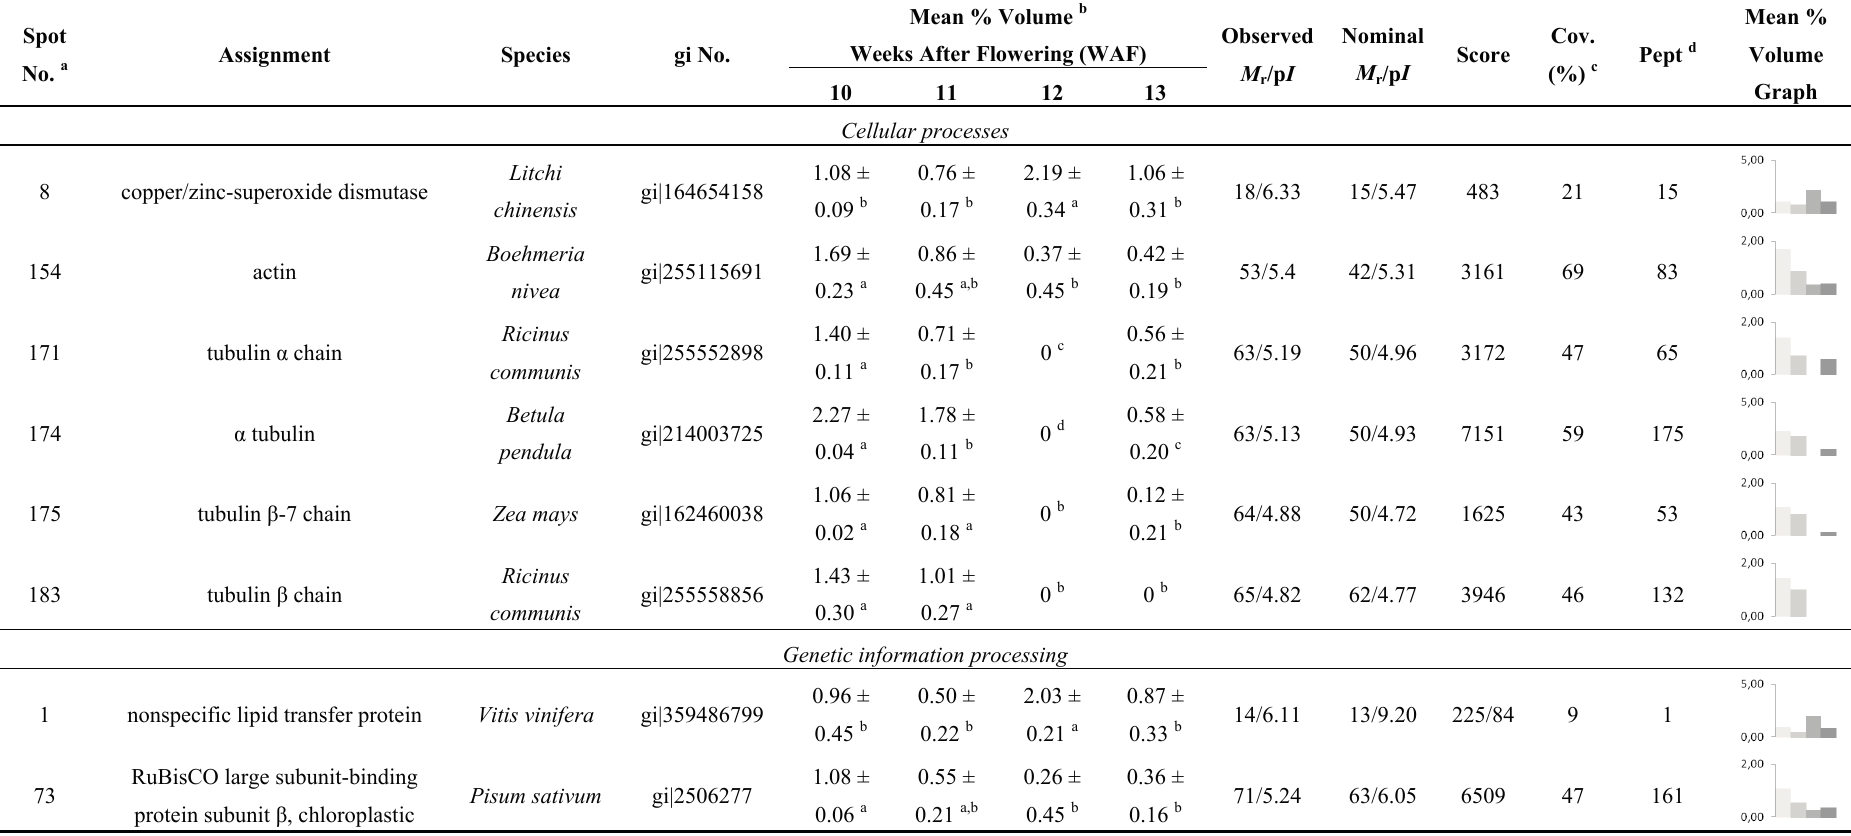
Table 1. Identification of proteins in Acer platanoides that significantly changed in abundance during the period of embryo morphogenesis. For each spot, values for nominal (computed) and observed p I s and M and the mean normalized volume of each of the analyzed variants are r indicated. Spots were subjected to analysis of variance (ANOVA) and the Tukey-Kramer HSD test (JMP software, SAS Institute, Cary, CA, USA) to select spots that significantly varied ( p < 0.05) in abundance during